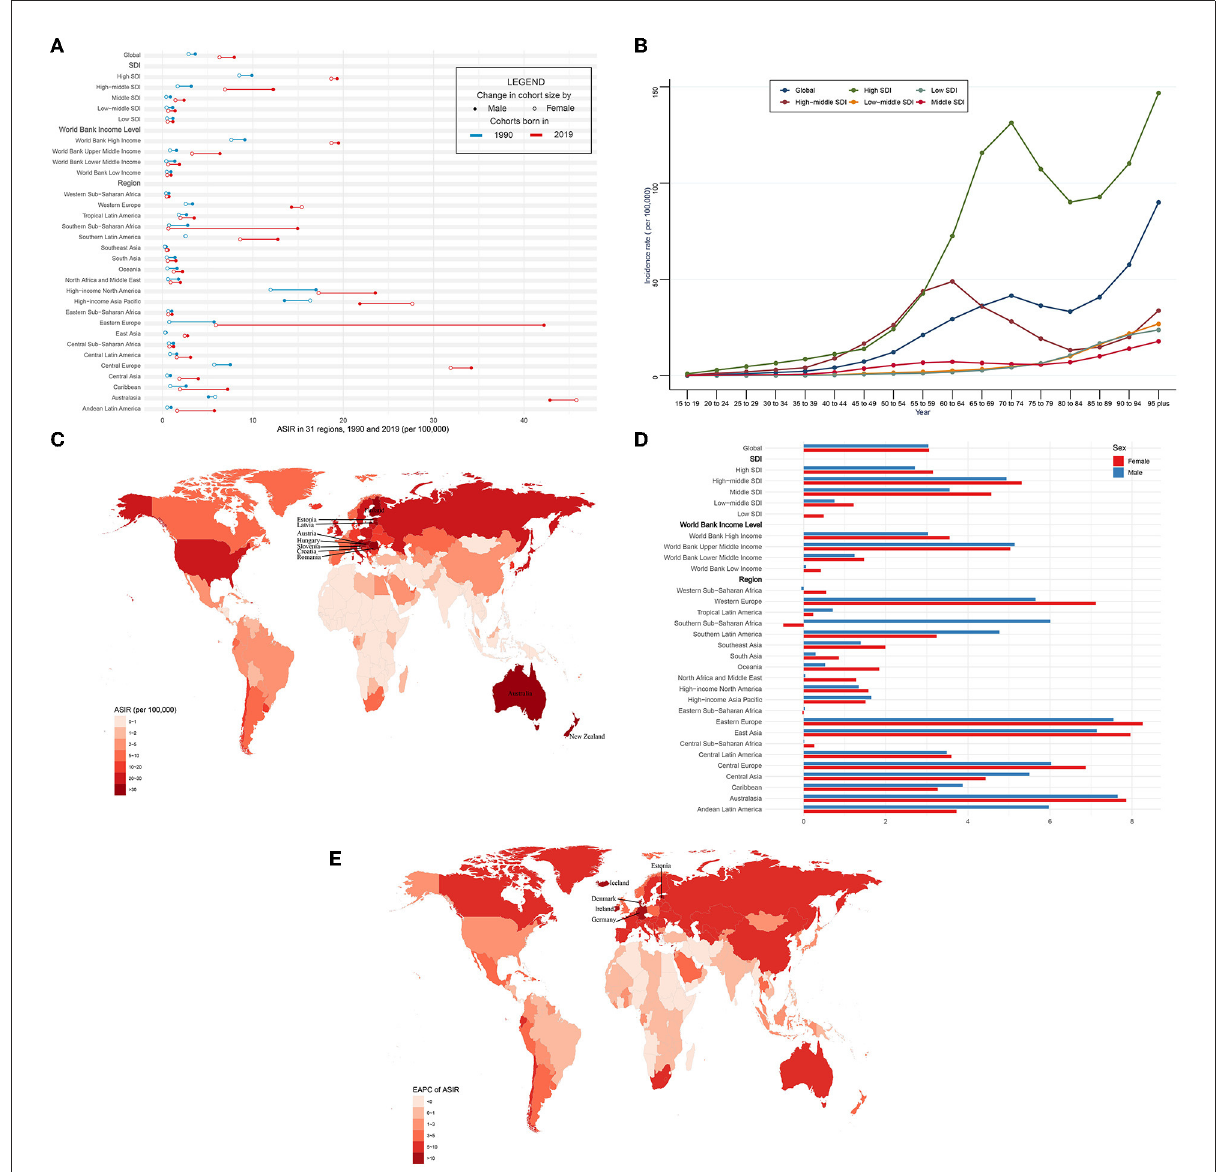
FIGURE1 ASIR and its trend of CAVD. (A) ASIR in 31 regions from 1990 to 2019. (B) Incidence rate stratified by age in the globe and 5 SDI regions in 2019. (C) ASIR in 204 countries and territories in 2019. (D) EAPC of ASIR in 31 regions from 1990 to 2019. (E) EAPC of ASIR in 204 countries and territories from 1990 to 2019. CAVD, calcific aortic valve disease; ASIR, the age-standardized incidence rate; SDI, socio-demographic index; EAPC, estimated annual percentage